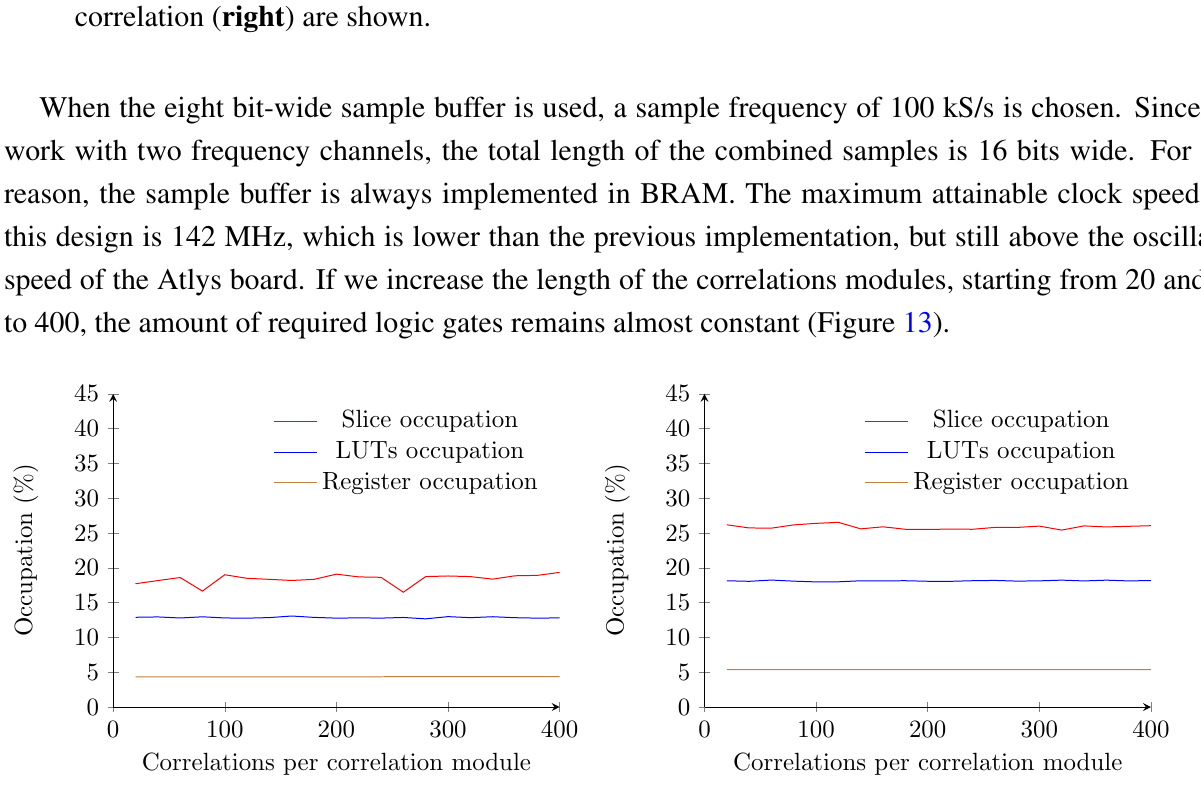
Figure 13. Occupation of the receiver using the optimized correlation implementation with an eight bit-wide sample buffer. One transmitter correlation ( left ) and four transmitters correlation ( right ) are